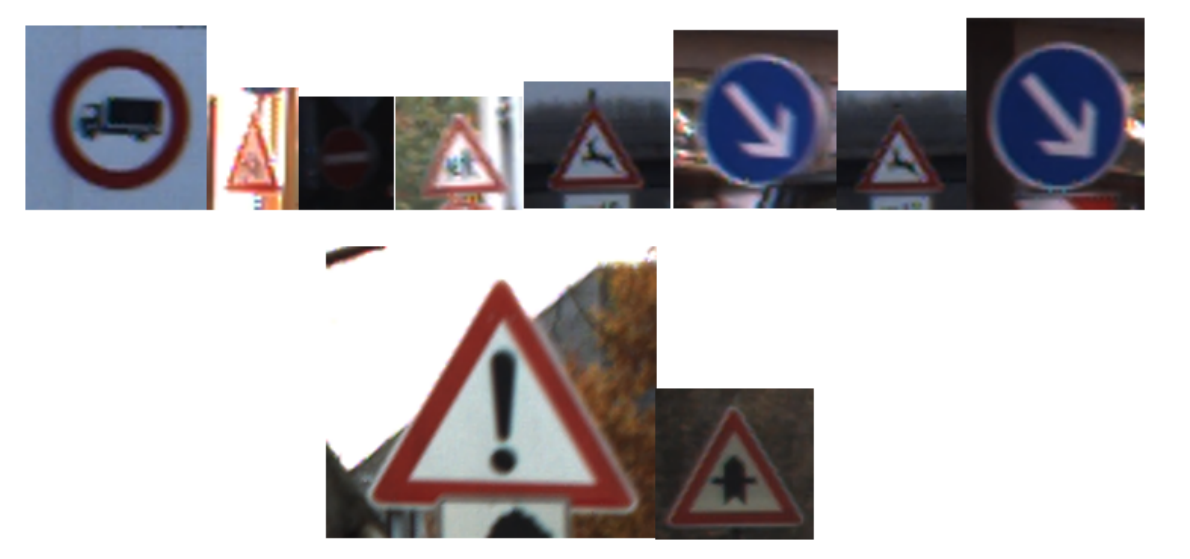
Figure 9. Some of the images from the dataset.